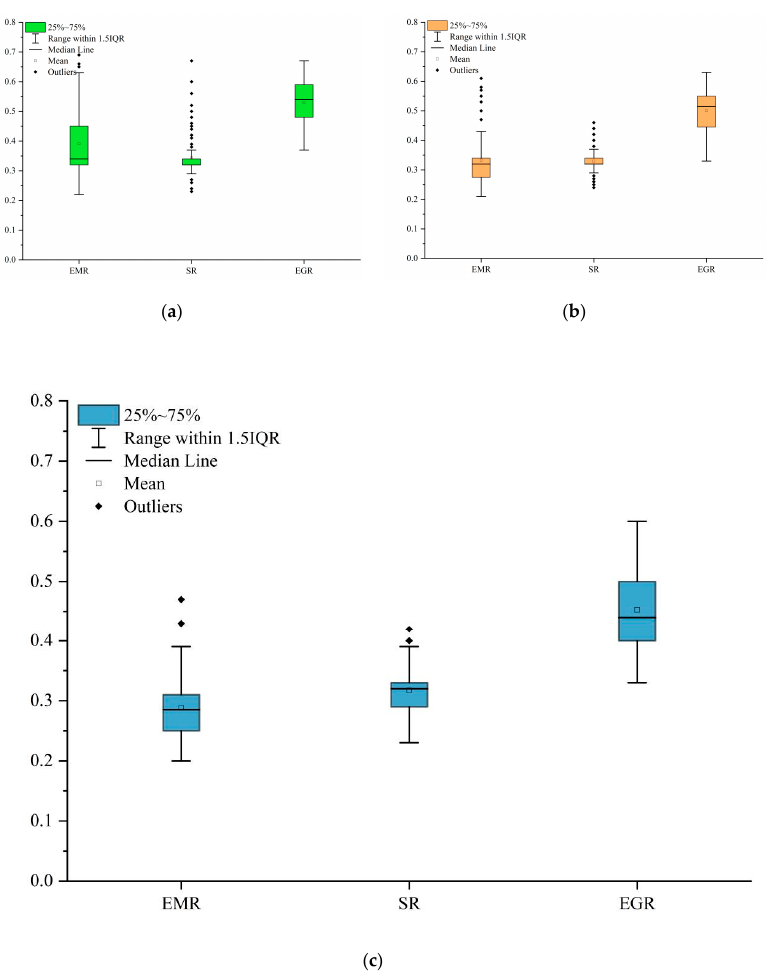
Figure 4. Economic-social-ecological resilience of China’s urban agglomerations. ( a ) Growing ur- ban agglomerations. ( b ) Developing urban agglomerations. ( c ) Promoting urban agglomerations.